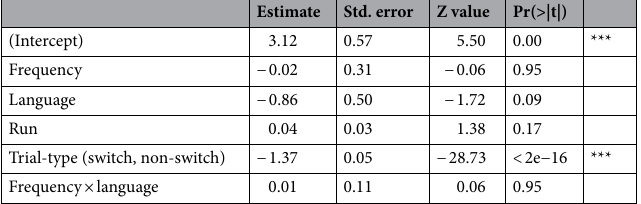
Estimate Std. error Z value Pr(>|t|)